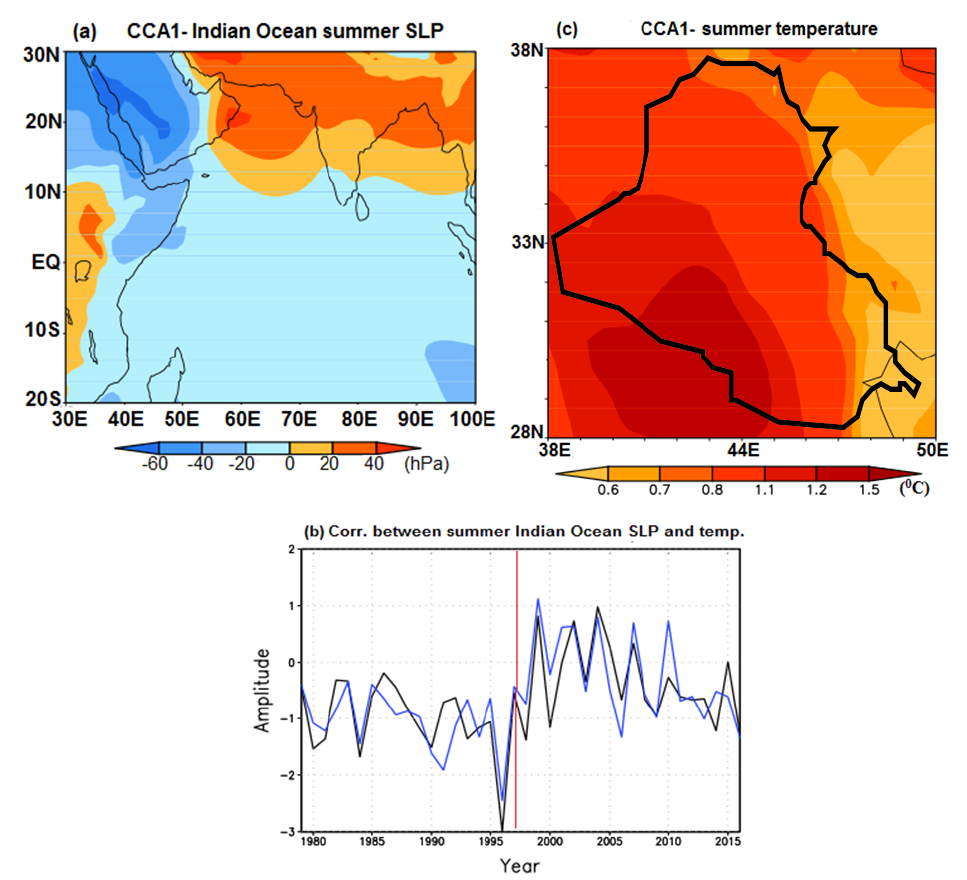
Figure 8. First pair derived through CCA between summer SLP of Indian Ocean sector and Iraq summer temperature fields extending over the 1979 – 2016 period. ( a ) SLP map, explaining 7.73% of the total variance; ( b ) SLP (blue line), Iraq temperature (black line) time series associated to patterns in panels (a and c), the correlation between these two time series is 0.88; ( c ) temperature map, explaining 66.31% of the total variance. The black contour line in panel (c) marks the Iraq border.